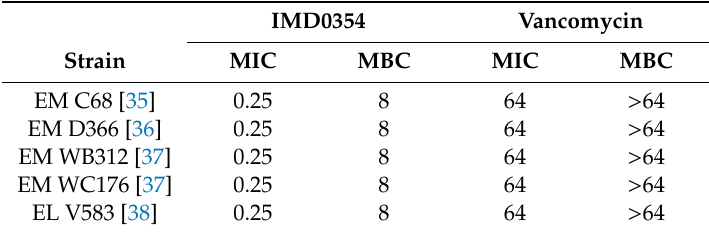
Minimum inhibitory concentration ( µ g / mL) of NF- κ B inhibitors IMD0354 against vancomycin-resistant enterococci (VRE) clinical strains.